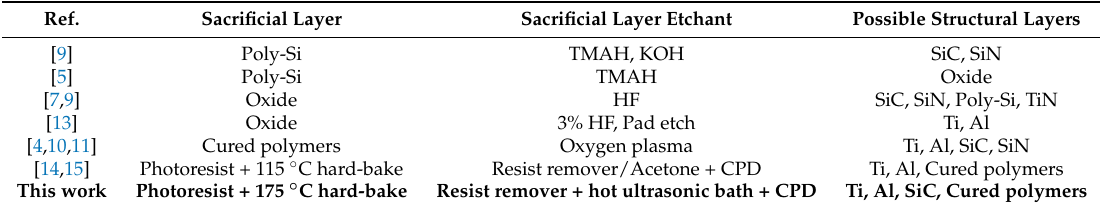
Table 1. Possible structural layers supported by different sacrificial layers, including that proposed in this work ( bold